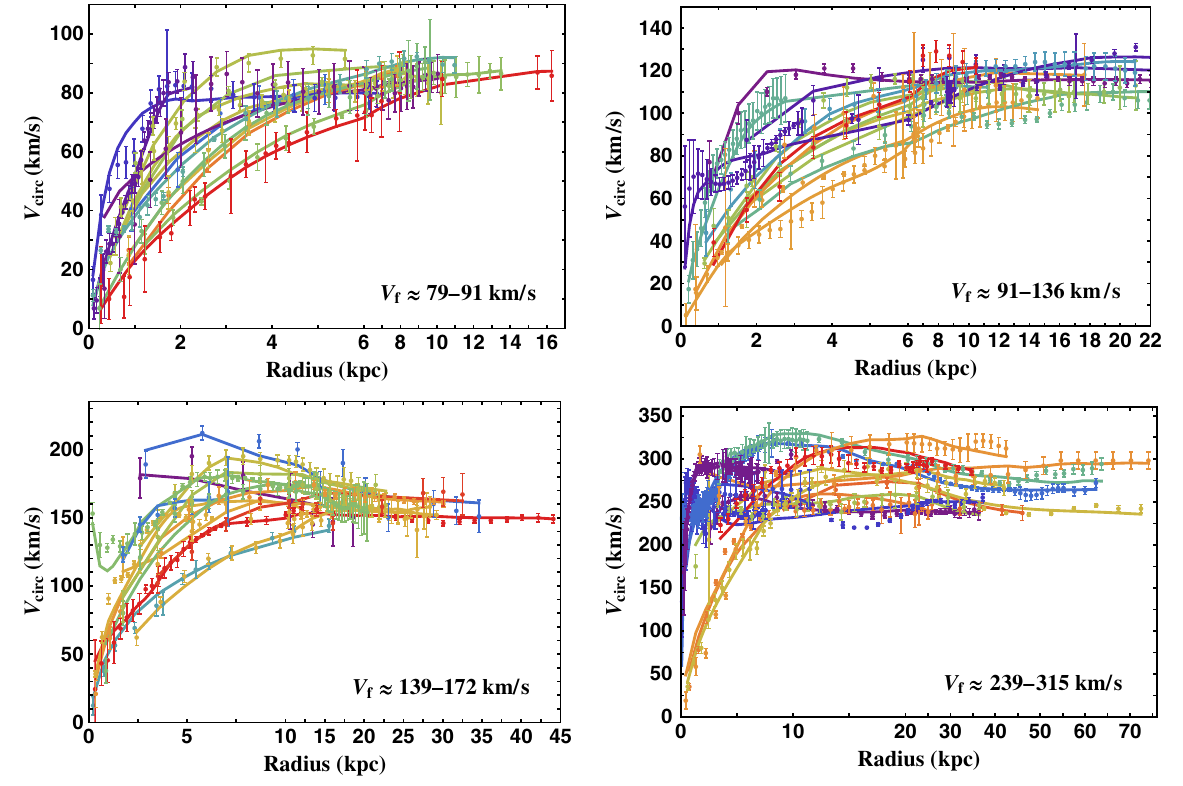
FIG. 1. SIDM fits (solid) to the diverse rotation curves across a range of spiral galaxy masses, where we take σ = m ¼ 3 cm 2 = g. The data points with error bars are from the SPARC data set [18]. Each panel contains 14 galactic rotation curves that are selected to have similar flat rotation velocities at their furthest radial data points, and the corresponding V 239 – 315 km = s, spanning the mass range of the galaxies considered in this work. The galaxies are colored according to their relative surface brightness in each panel from low (red) to high